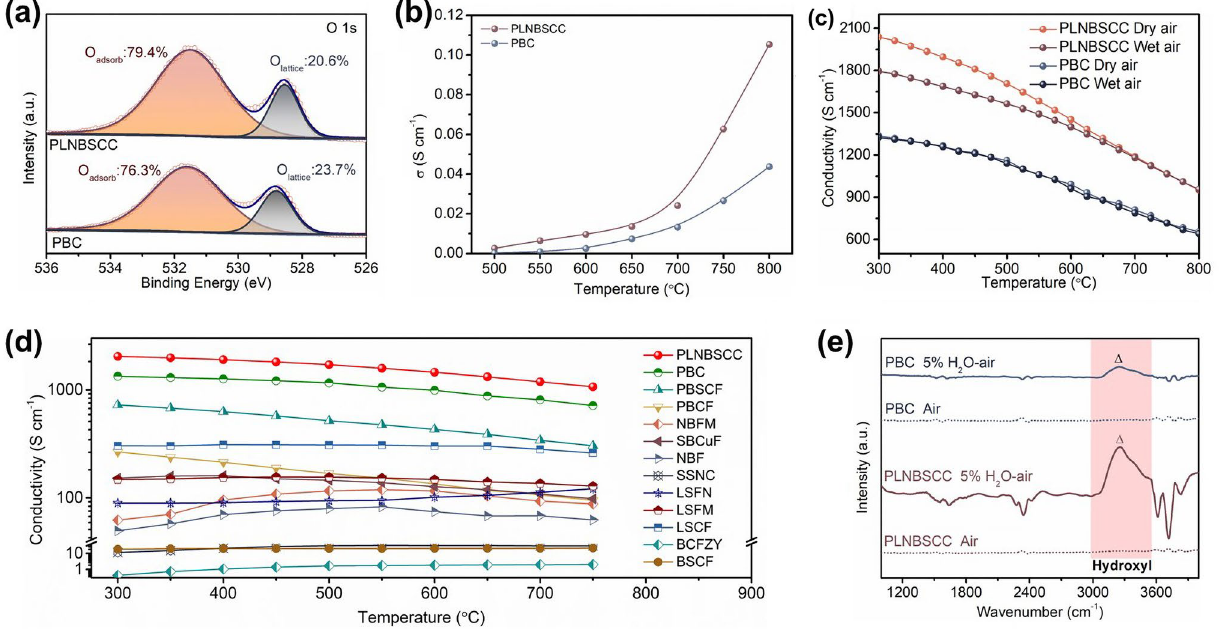
Fig. 3 a XPS spectra of O 1 s of PLNBSCC and PBC oxides. b O 2− conductivities of PLNBSCC and PBC oxides in the temperature range of 500–800 °C. c Electrical conductivity of PLNBSCC and PBC oxides measured under dry and wet air (3% H 2 O) from 300 to 800 °C. d Electrical conductivity of PLNBSCC compared to most typical air electrodes at 300–750 °C. e IR spectra of PLNBSCC and PBC oxides after treatment at 400 °C for 2 h in dry air and 5% H 2